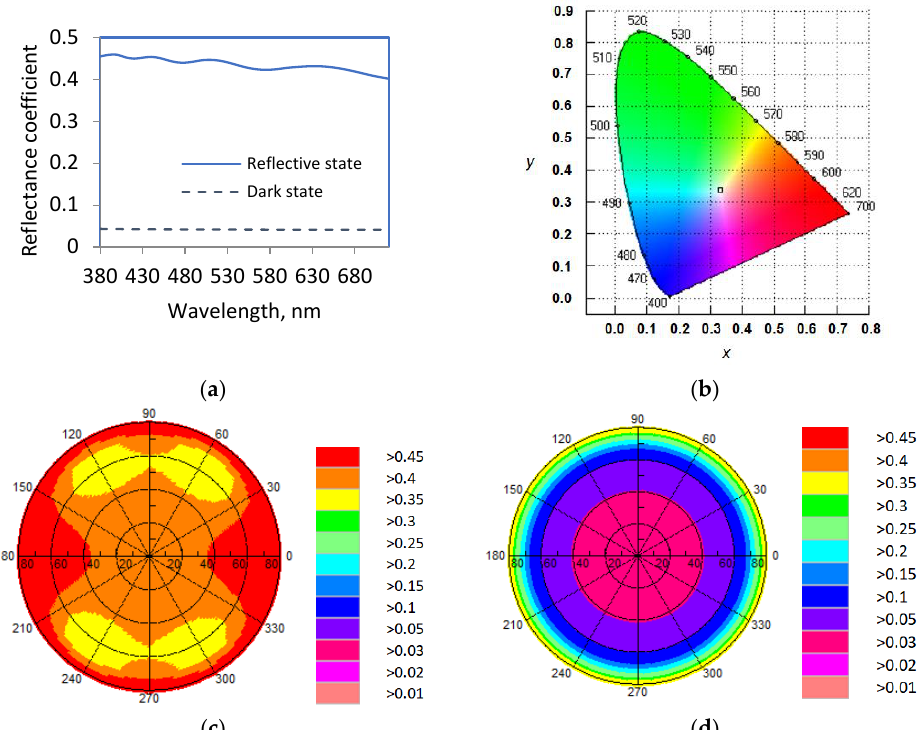
Figure 4. Color online. ( a ) Reflectance spectra for reflective and dark states of the ORW e-paper; ( b ) simulated CIE 1931 chromaticity diagram. Hemispherical directional reflectance for the twist angle of ( c ) 90° and ( d ) 0°. Liquid crystal layer thickness: 13.64 μm.